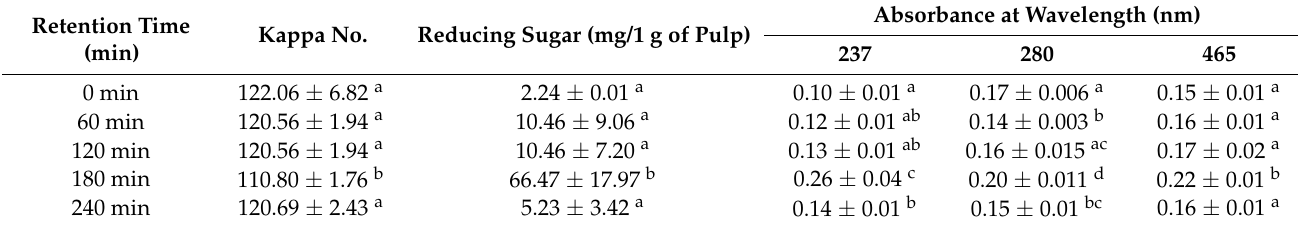
Table 2. Effect of retention time on pulp